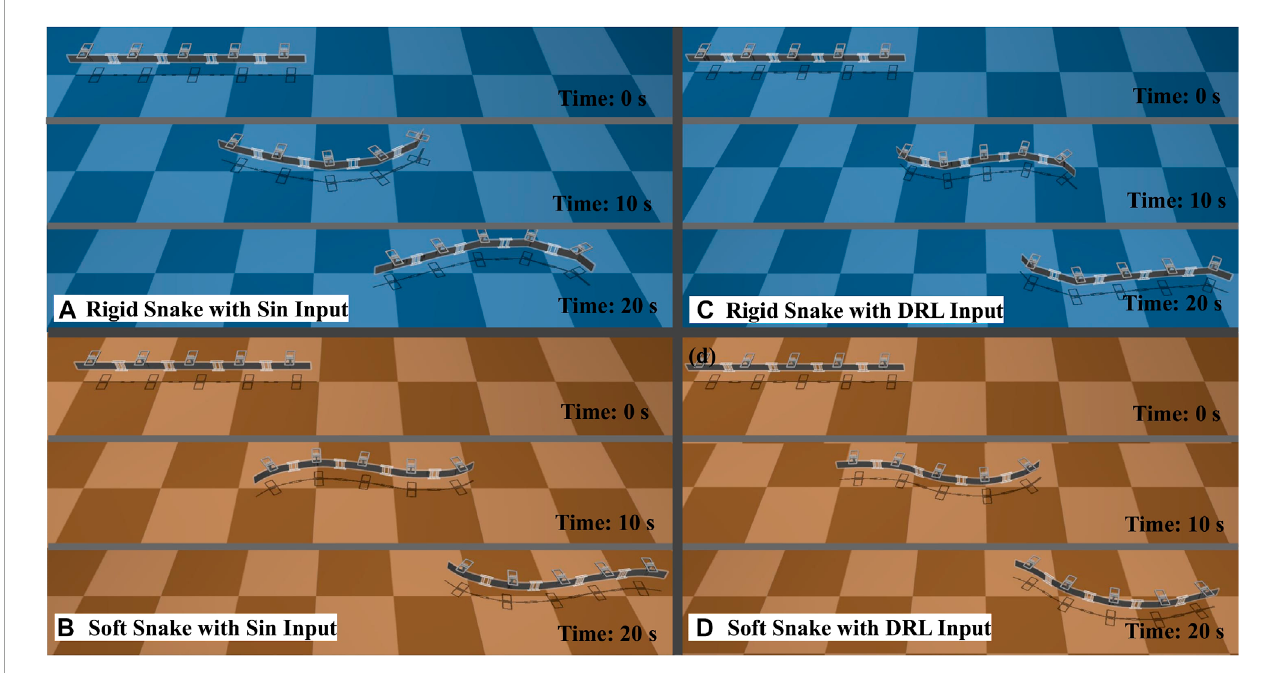
FIGURE 10 Test results for the four selected gaits. (A) The rigid snake robot is controlled by the gait equation controller. (B) The rigid snake robot is controlled by the DRL controller. (C) The soft snake robot is controlled by the gait equation controller. (D) The soft snake robot is controlled by the DRL controller.